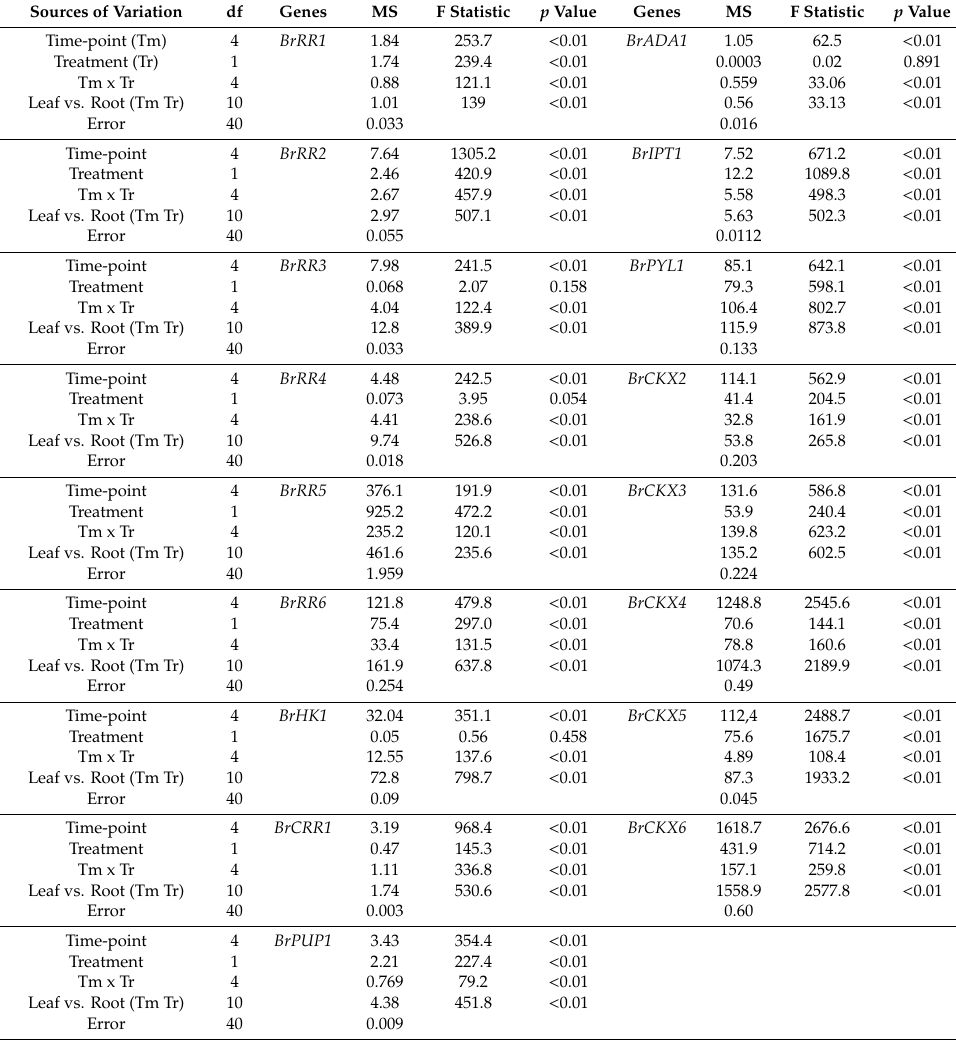
Table 2. Sources of variation, degrees of freedom (df), mean squares (MS), F statistic, p value for relative expression levels of 17 cytokinin-biosynthesis related genes in leaf and root samples at five di ff erent time-points (1, 3, 14, 28, and 35 days after inoculation) under two di ff erent treatments (mock and inoculation with Seosan-isolate of P. brassicae ) in Chinese cabbage cultivar “Bullam-3-ho.” Sources of Variation df Genes MS F Statistic p Value Genes Time-point (Tm)